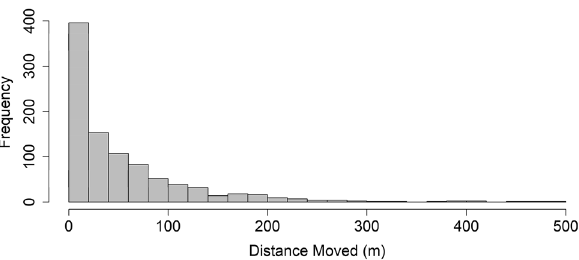
Figure 2. Frequency distribution of average distance moved (straight-line distance between successive locations/number of intervening days) per day for radiotracked brown treesnakes (BTS) in this study. The distribution was significantly right-skewed (Skewness = 2.55, SE of Skewness = 0.08).